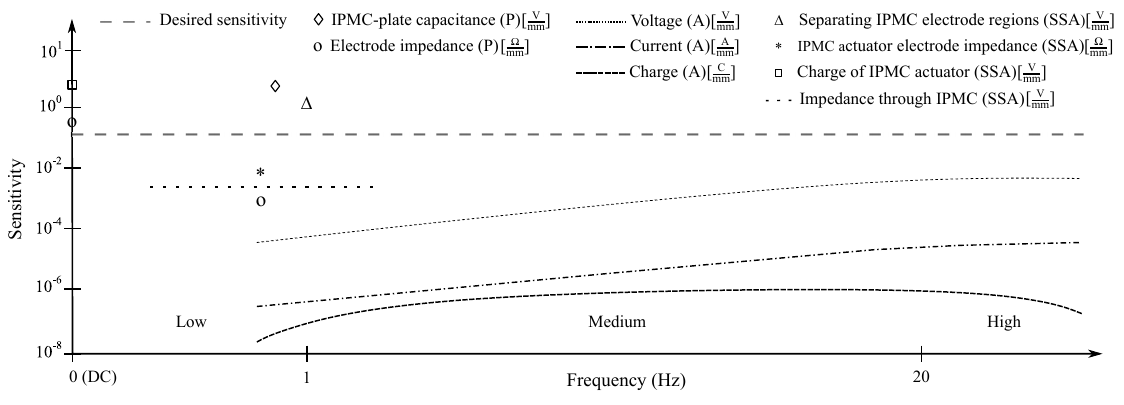
Figure 22. Qualitative comparison of the reported IPMC sensing and SSA methods. Shown sensitivities base on the experimental results of the respective studies. ‘A’ and ‘P’ respectively denote active and passive methods. Please note that these sensitivities are given in several different units, and therefore are not directly